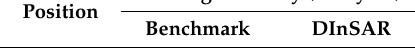
Table 5. DInSAR vs. levelling.